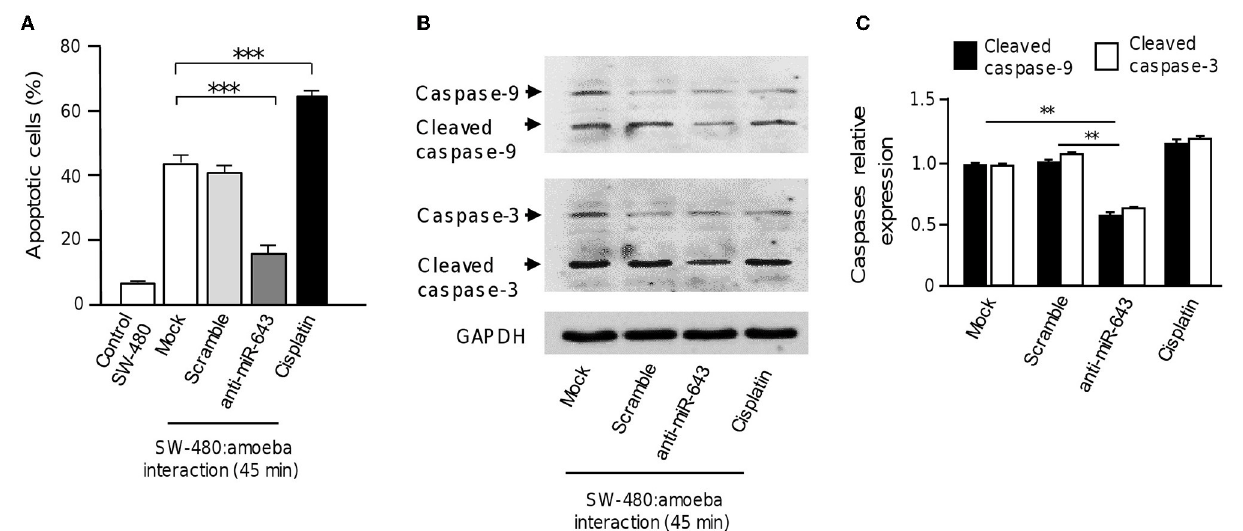
FIGURE 5 | Inhibition of miR-643 impairs apoptosis of SW-480 cells interacting with trophozoites. (A) SW-480 cells were or not transfected with miR-643 inhibitor or scramble and interacting with trophozoites for 45min. Then apoptosis of SW-480 cells was quantified using annexin V assays. SW-480 cells without exposure to E. histolytica and cells treated with cisplatin (50 µ M, during 12h) were used as controls. (B) Protein extracts from miR-643 deficient SW-480 cells interacting with E. histolytica trophozoites for 45min and controls were submitted to Western blot assays using caspase-3 and caspase-9 antibodies. GADPH antibodies were used as loading control. (C) Immunodetected bands intensity in panel B were quantified by densitometry and normalized to GAPDH. Values are expressed relative to the control group (0h, interaction). ** p < 0.01; *** p <